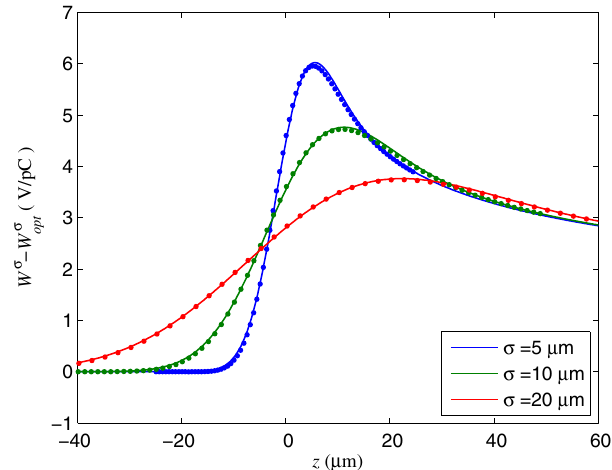
FIG. 13. Wake potentials from direct ECHO calculation (dots) ð z Þ and reconstructed from W 50 (cid:8) m ECHO eq